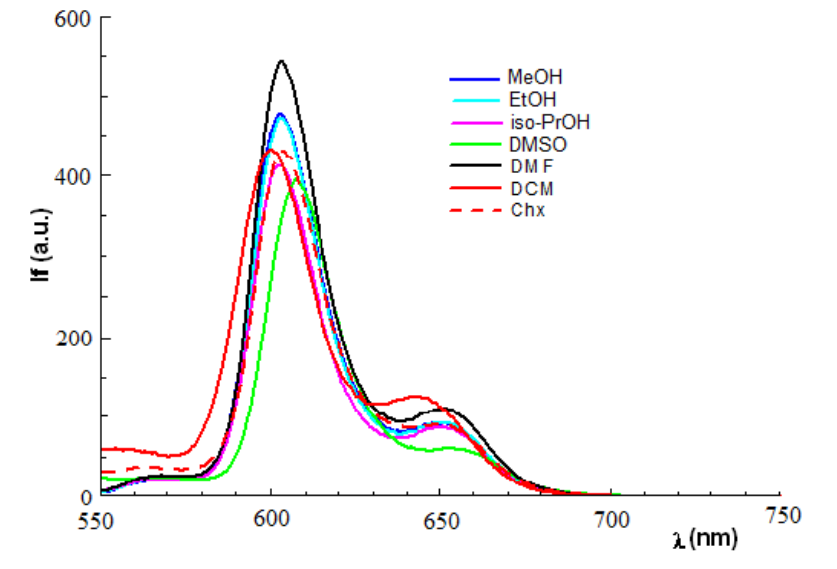
Figure 3. Fluorescence emission of Zn(II)-5-(4-hydroxyphenyl)-10,15,20-tris - (4-acetoxy-